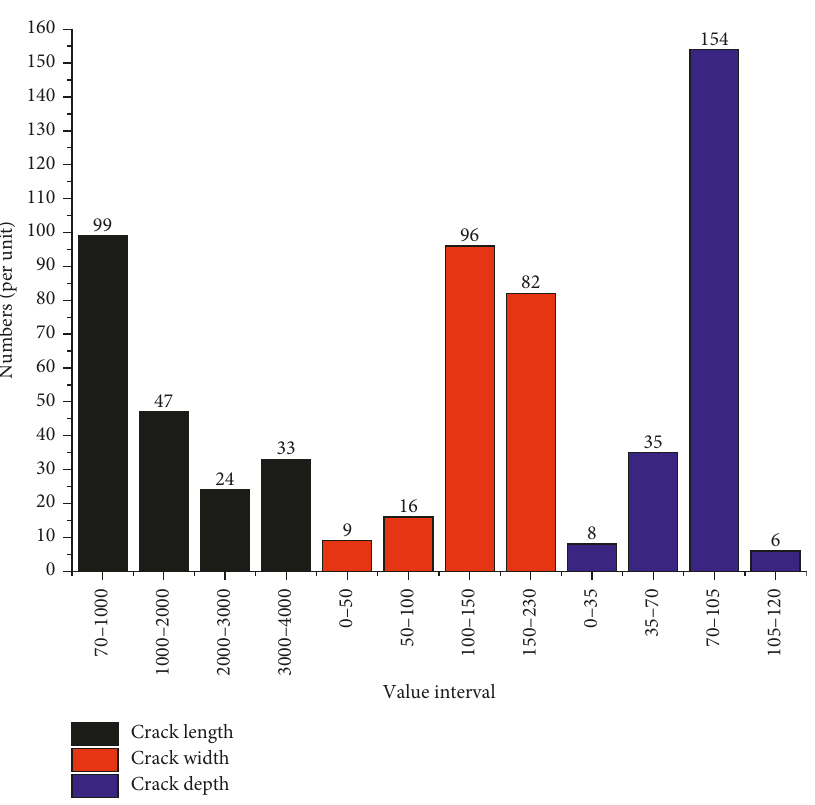
Figure 5: Length, width, and depth for the regional concrete spalling of segments. Table 2: Mix proportion of model soil.